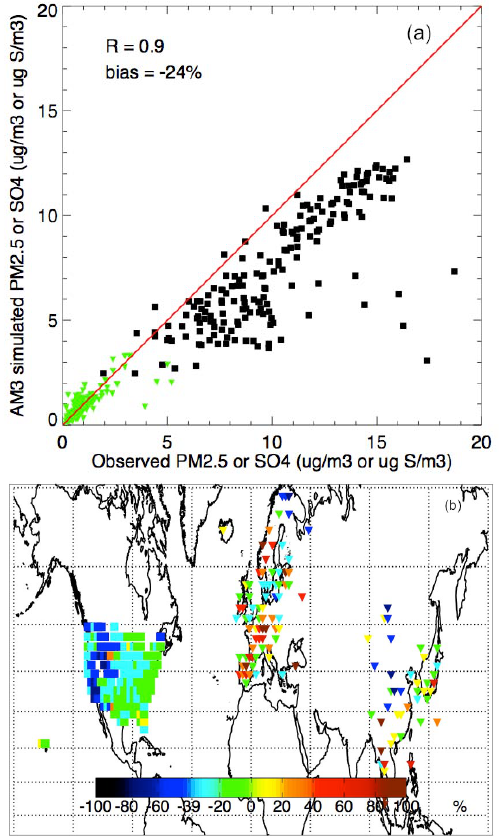
Fig. 2. (a) Scatter plot of AM3 “2000” simulated and observed an- nual mean concentrations of PM 2 . 5 (black squares, corresponding to the US observations) and sulfate (green triangles, correspond- ing to Asian and European observations). 1 : 1 line is shown in red. (b) Map of the relative difference (i.e., (model-obs)/obs) in PM 2 . 5 (squares) or sulfate (triangles). PM 2 . 5 observations over the United States are from the US Air Quality System (AQS) Database (1997–2003 average, http://www.epa.gov/ttn/airs/airsaqs/); sulfate observations over Europe are from the European Monitoring and Evaluation Programme (EMEP, 1995–2004, http://www.emep.int/). Sulfate observations over East Asia are from the Acid Deposition Monitoring Network in East Asia (EANET, http://www.eanet.cc/ product/index.html), collected from Liu et al. (2009a) and Zhang et al.